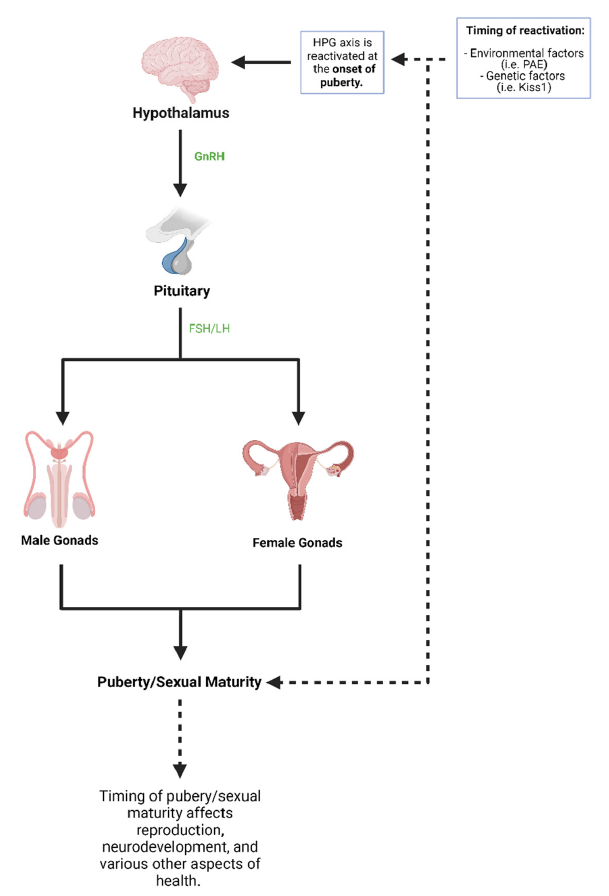
Figure 2. Puberty and hypothalamic–pituitary–gonadal (HPG) axis. The HPG axis works using var- ious organs and hormones that lead to puberty and sexual maturity. The HPG axis is first active